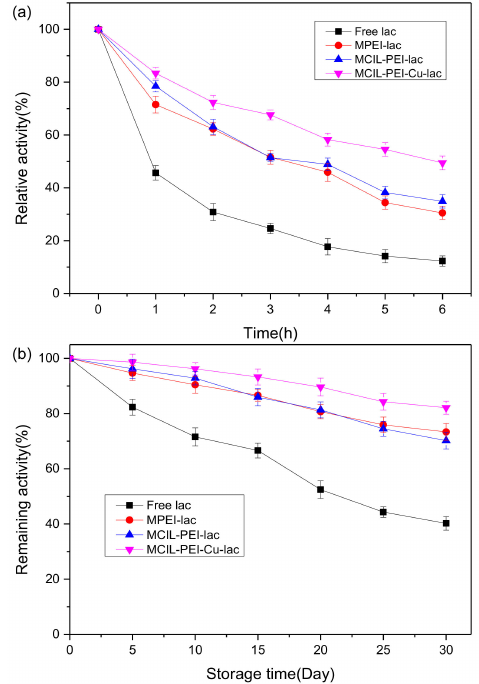
Figure 5. Studies on thermal ( a ) and storage stability ( b